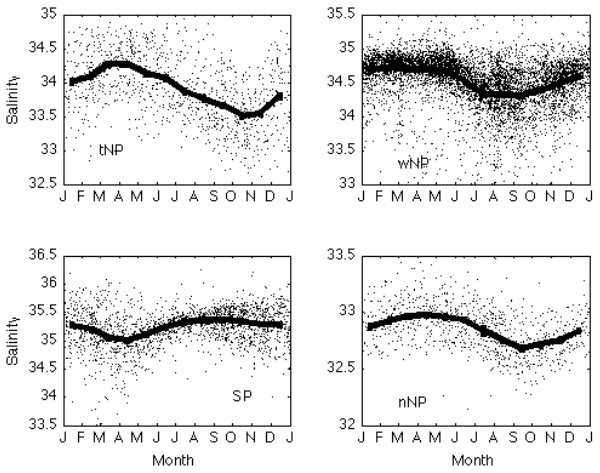
Fig. 13. SLS for the areas depicted in Fig. 12 and Table 1, plotted as a single year. Note that y-axis limits are different for each panel. Lettering in the bottom of each panel corresponds to areas described in Table 1. Dots are individual measurements, with only 10% of points plotted for clarity. Solid curves are monthly